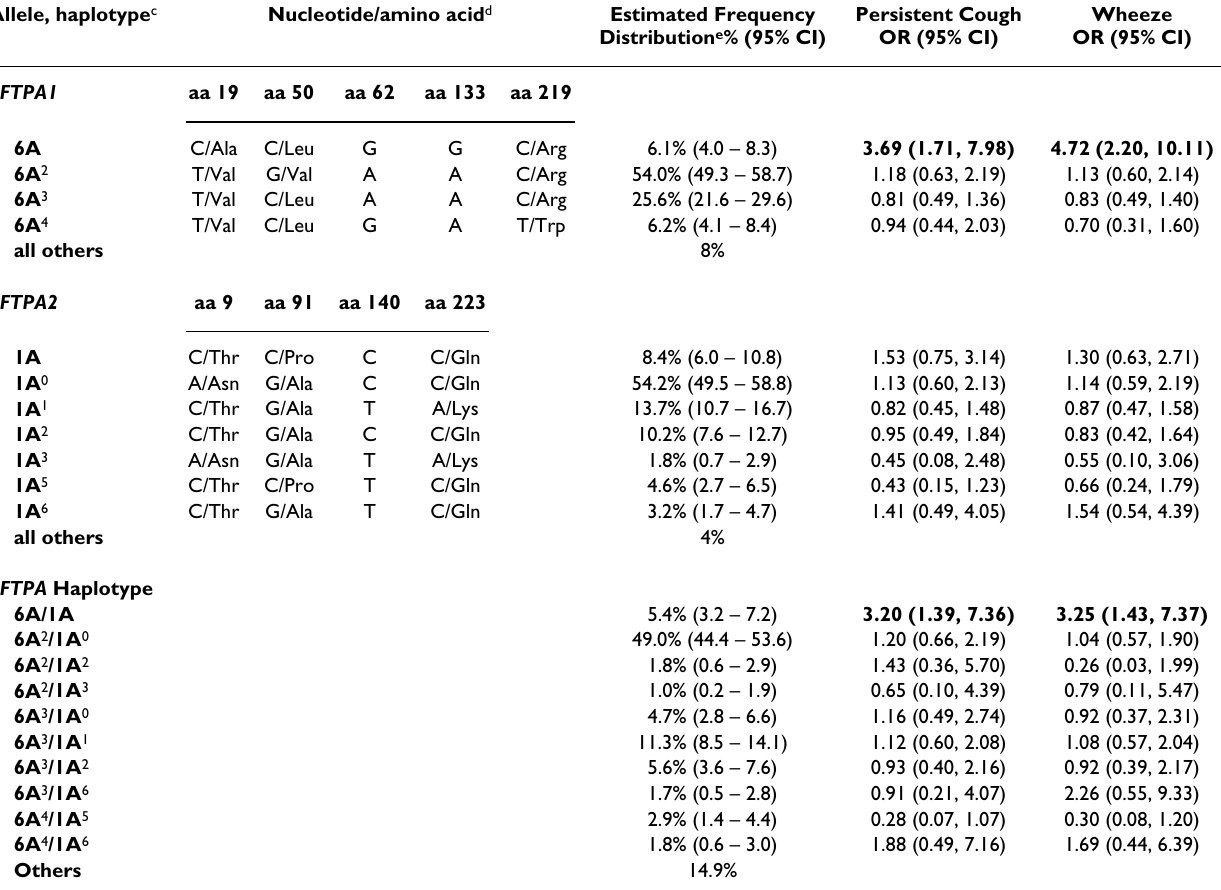
Table 3: Unadjusted associations between surfactant protein A ( SFTPA1 , SFTPA2 ) haplotypes and persistent cough or wheeze in the first year of life. a Unadjusted odds ratios (OR) and 95% confidence intervals (CI) are from ordered logistic regression models predicting symptom frequency. b (CT and MA, 1998 – 2000) Allele, haplotype